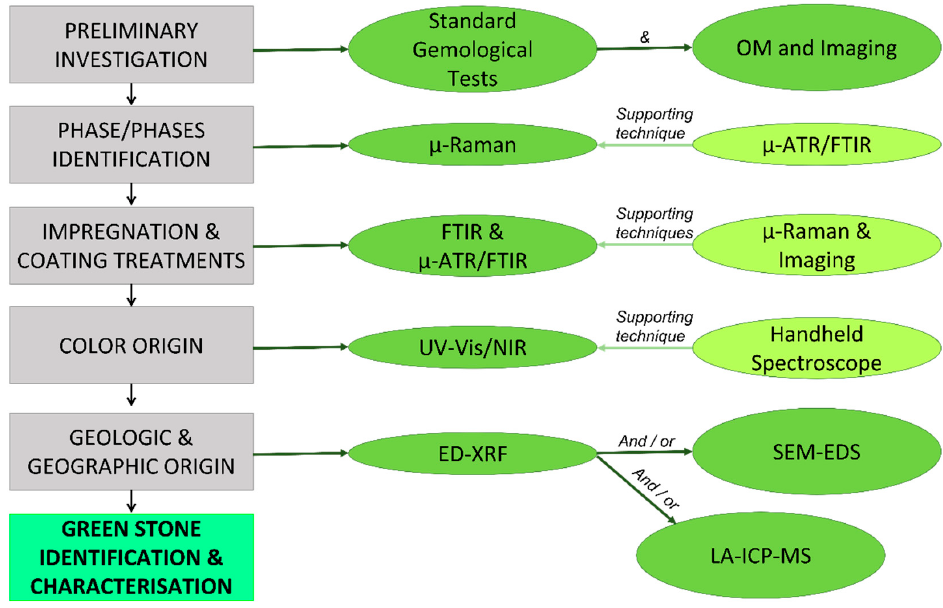
Figure 11. A summary of the multidisciplinary analytical approach applicable to the identification of Green Stones and the characterization process.